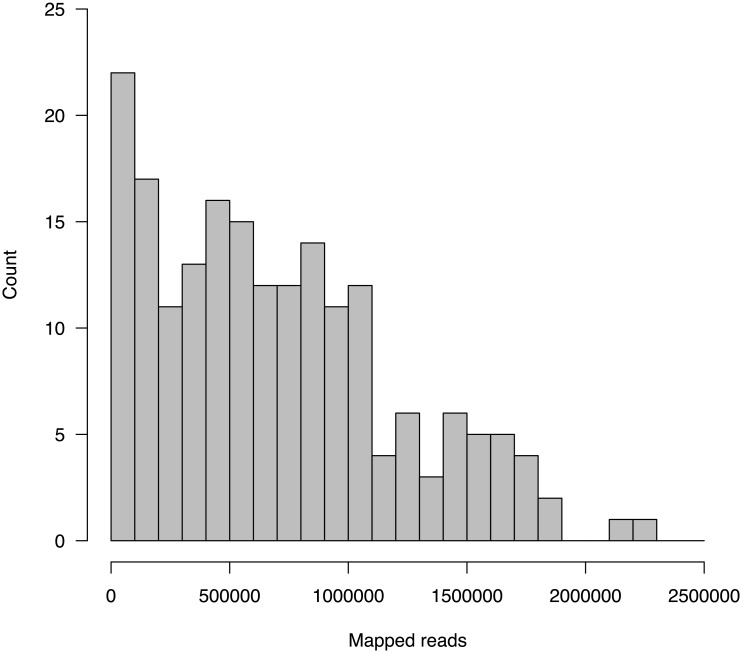
Histogram of read counts mapped to the reference genome.